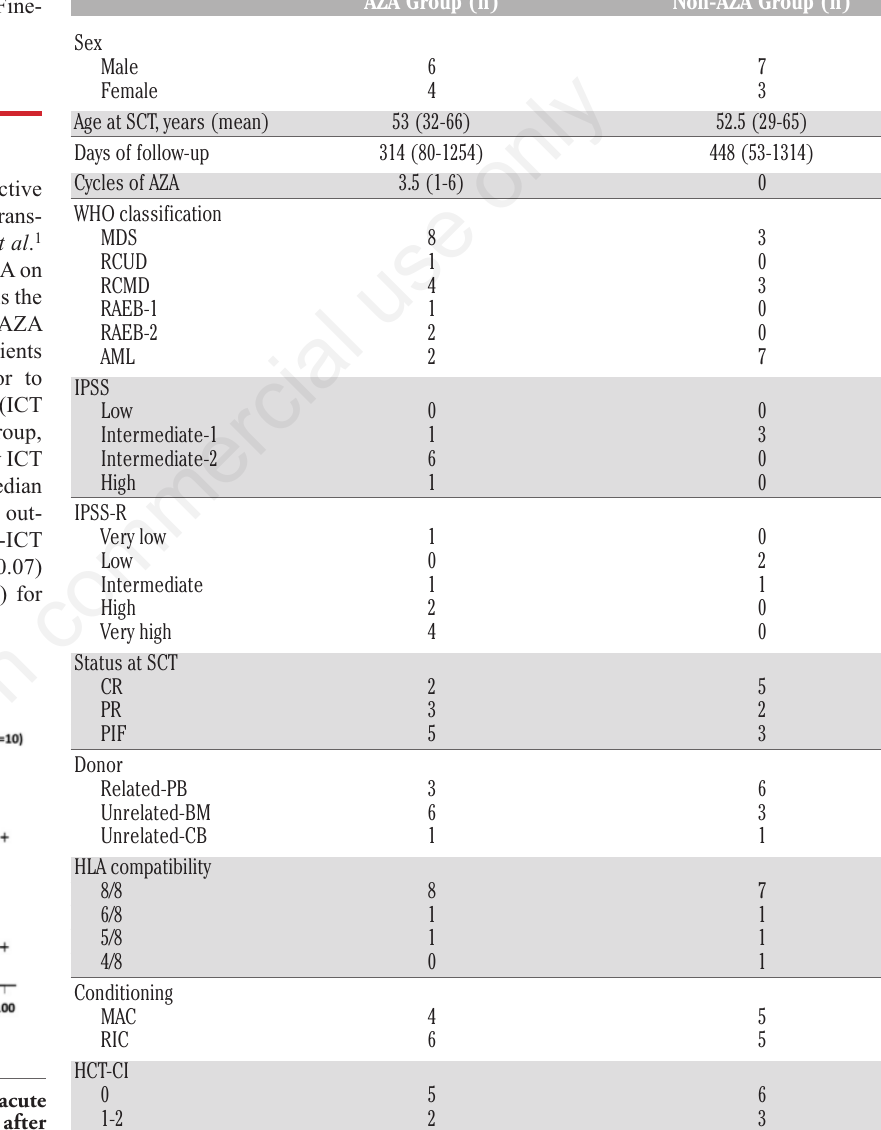
Table 1. Characteristics of participating patients and disease.